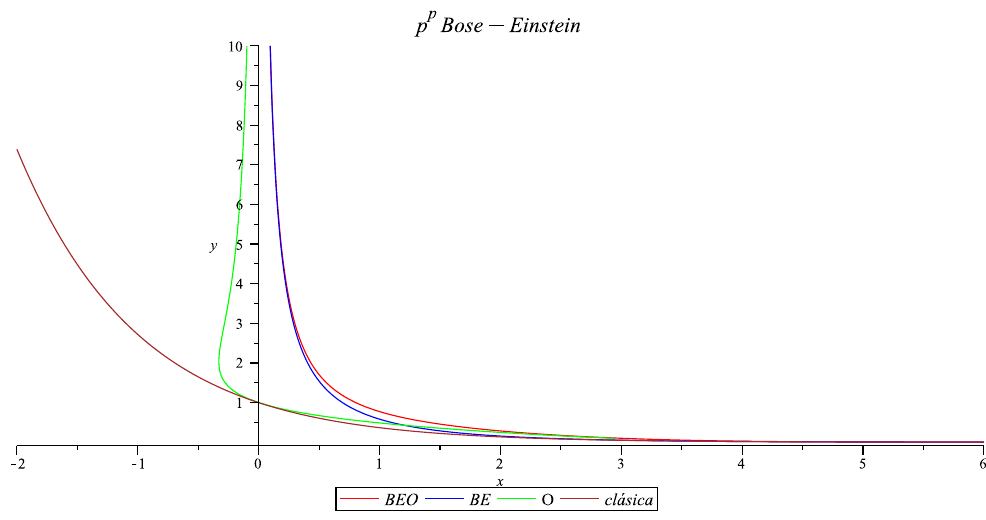
Figure 5. Comparison of BE with BEO ( n corresponds to BEO, blue line to BE usual, green line to g